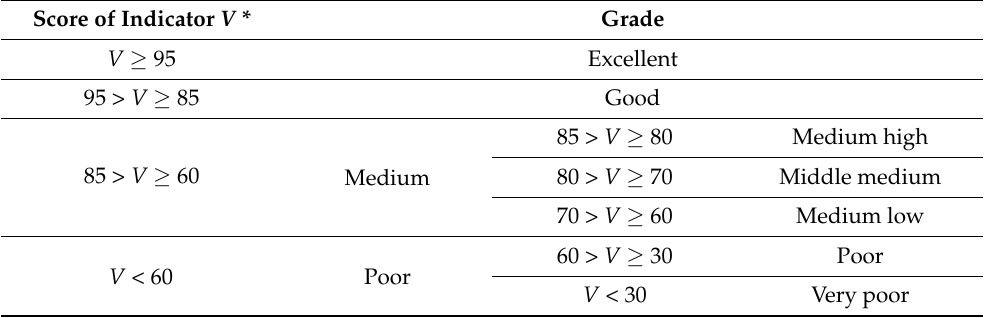
Table 5. Grading standard for evaluation indicators of the RHI. Score of Indicator V * Grade V ≥ 95 Excellent 95 > V ≥ 85